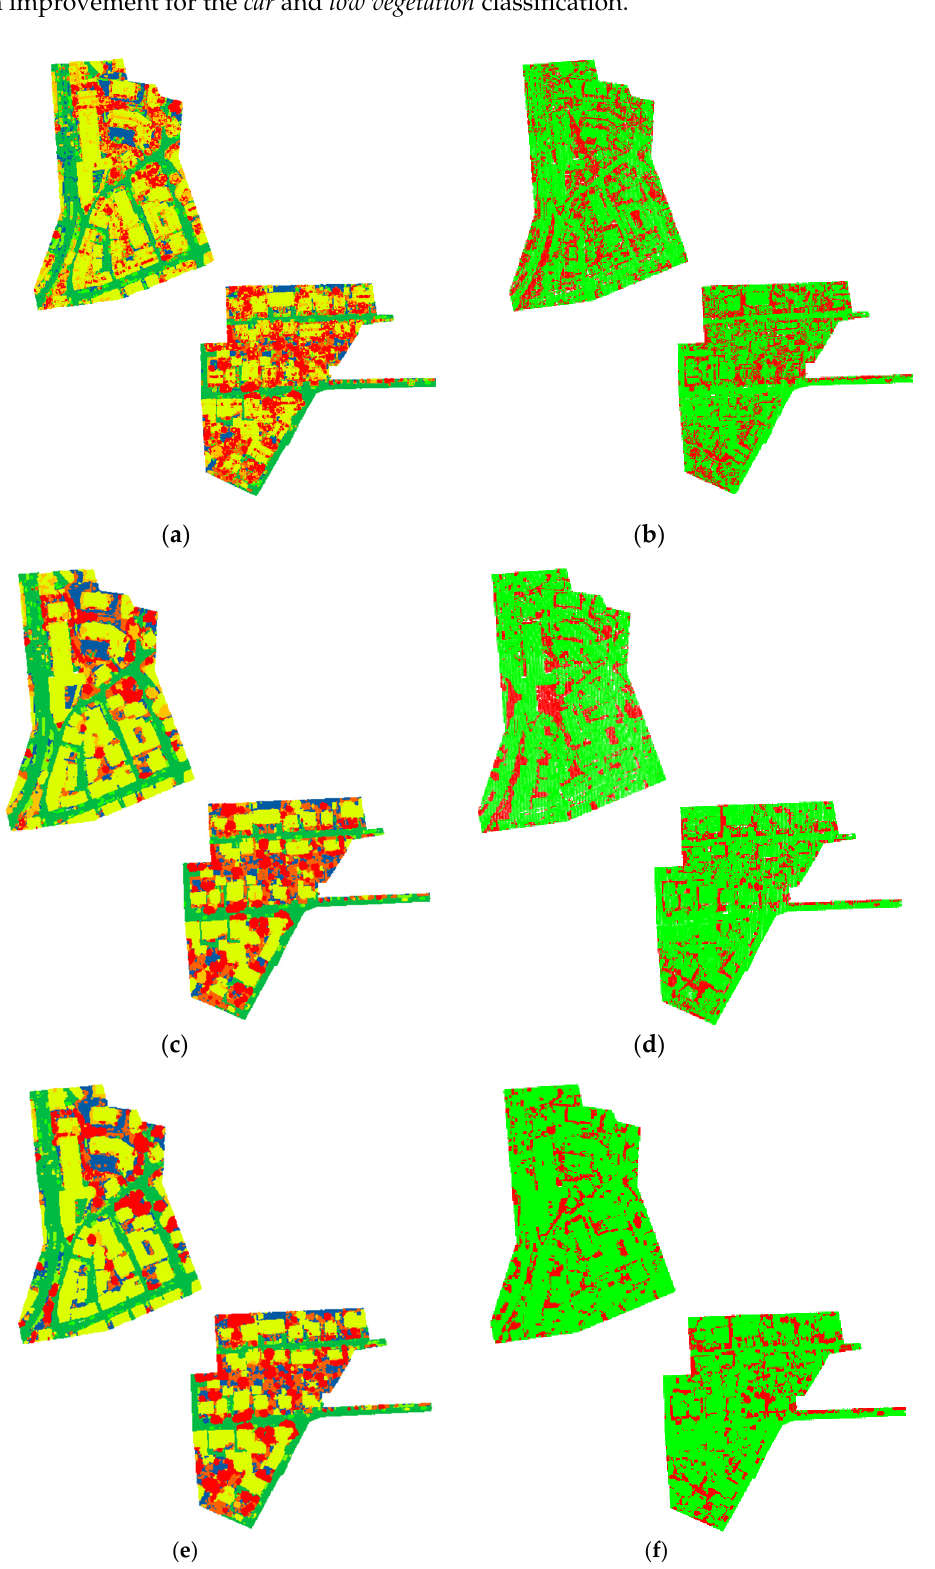
Figure 11. The semantic classification results and classification errors for the Vaihingen Dataset: ( a )– ( b ) RF; ( c ) – ( d ) CRF; ( e ) – ( f ) LCS-CRF.